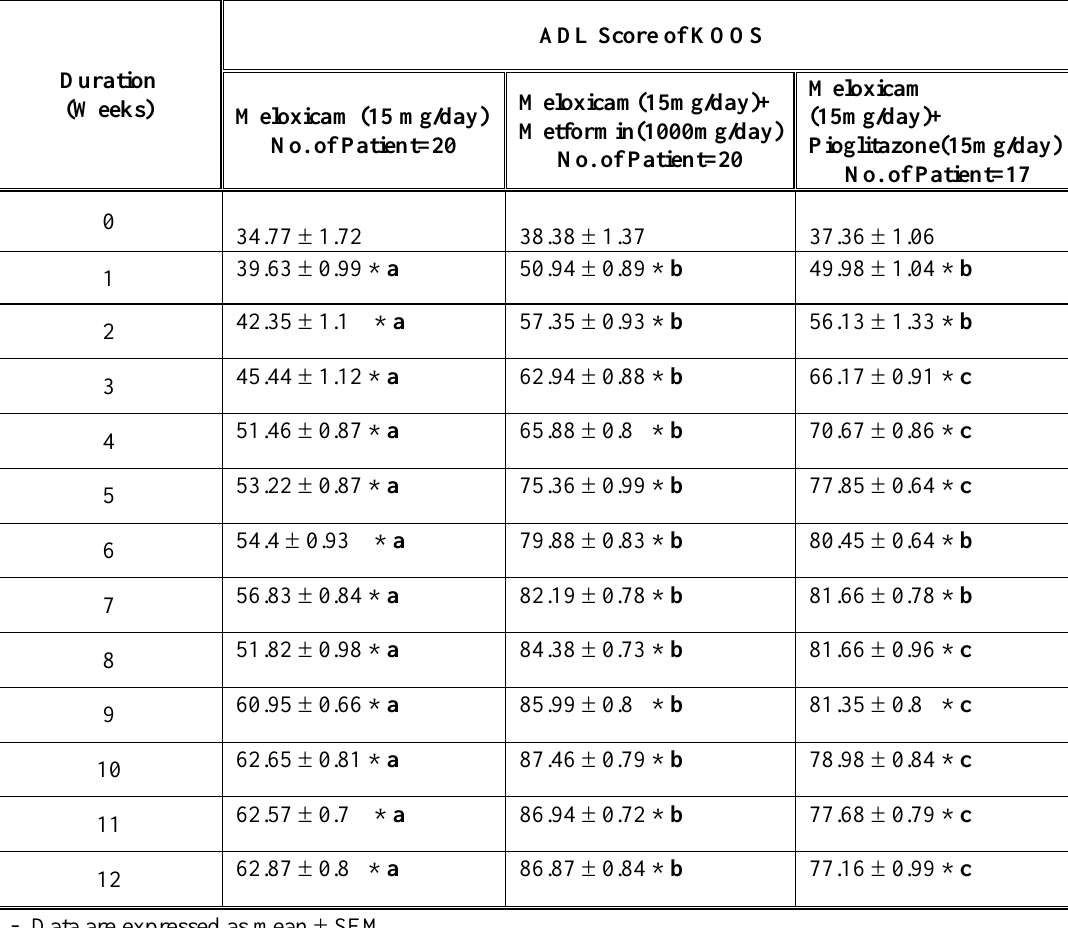
Table (3): Effects of treatment with meloxicam alone, combination of meloxicam + metformin, and meloxicam + pioglitazone on Daily Living Activity (ADL) score in osteoarthritic